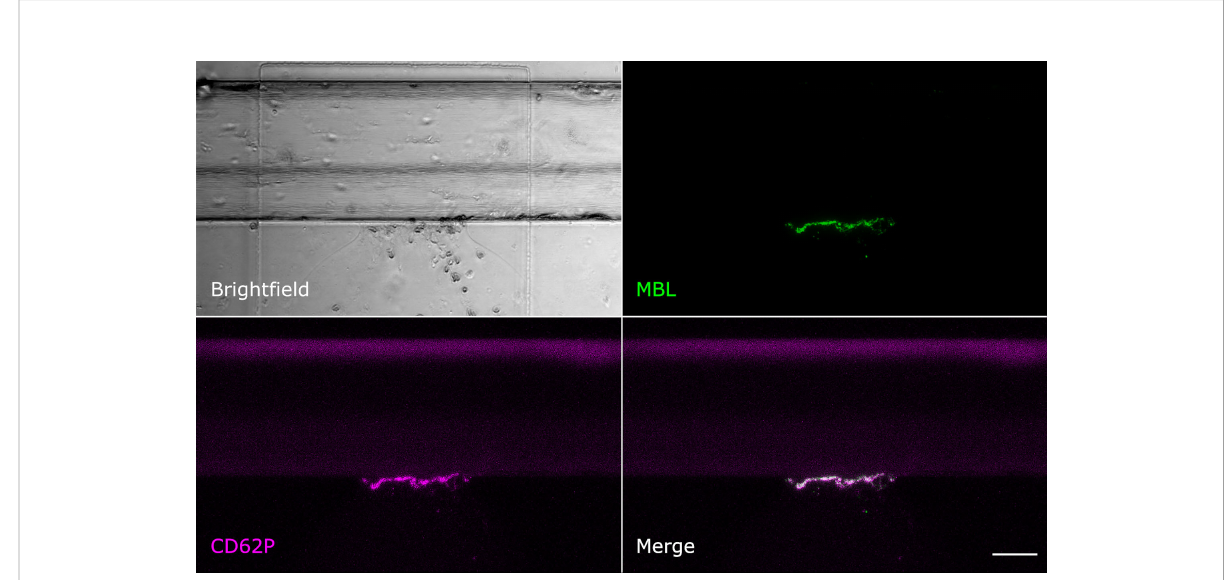
FIGURE 3 MBL colocalises with activated platelets. Micro fl uidic bleeding model 60 min after injury. From top left to bottom right: Bright fi eld, anti-MBL signal (green), anti-CD62P signal (purple), and merged signals. CD62P-expressing activated platelets and MBL showed a complete colocalisation. Scale bar: 50